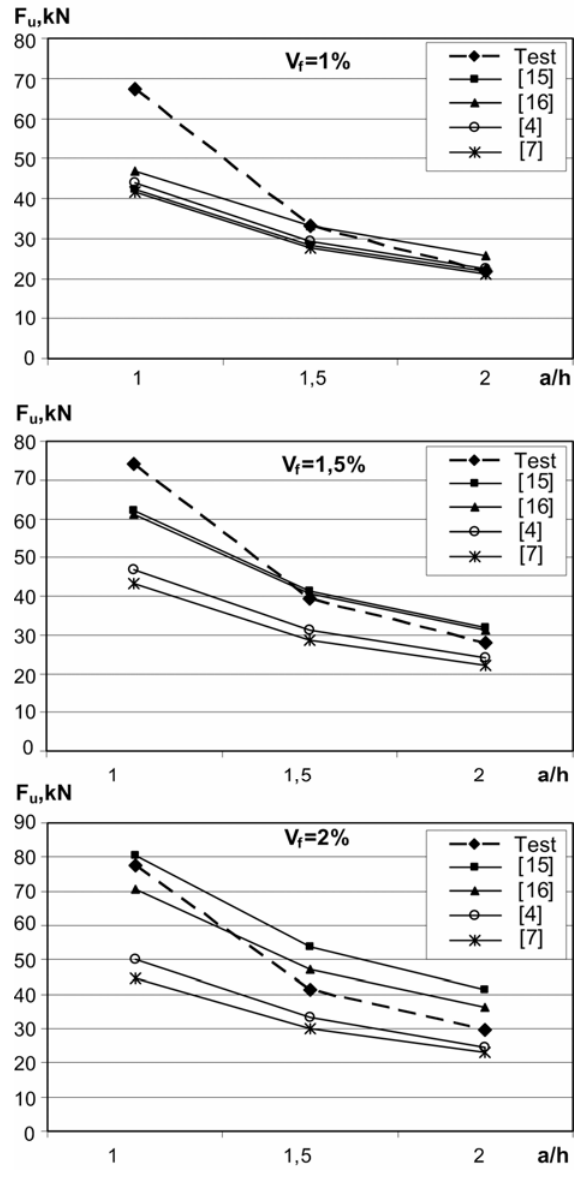
Fig 9. Influence of shear span ratio on load capacity at various fibre volume f